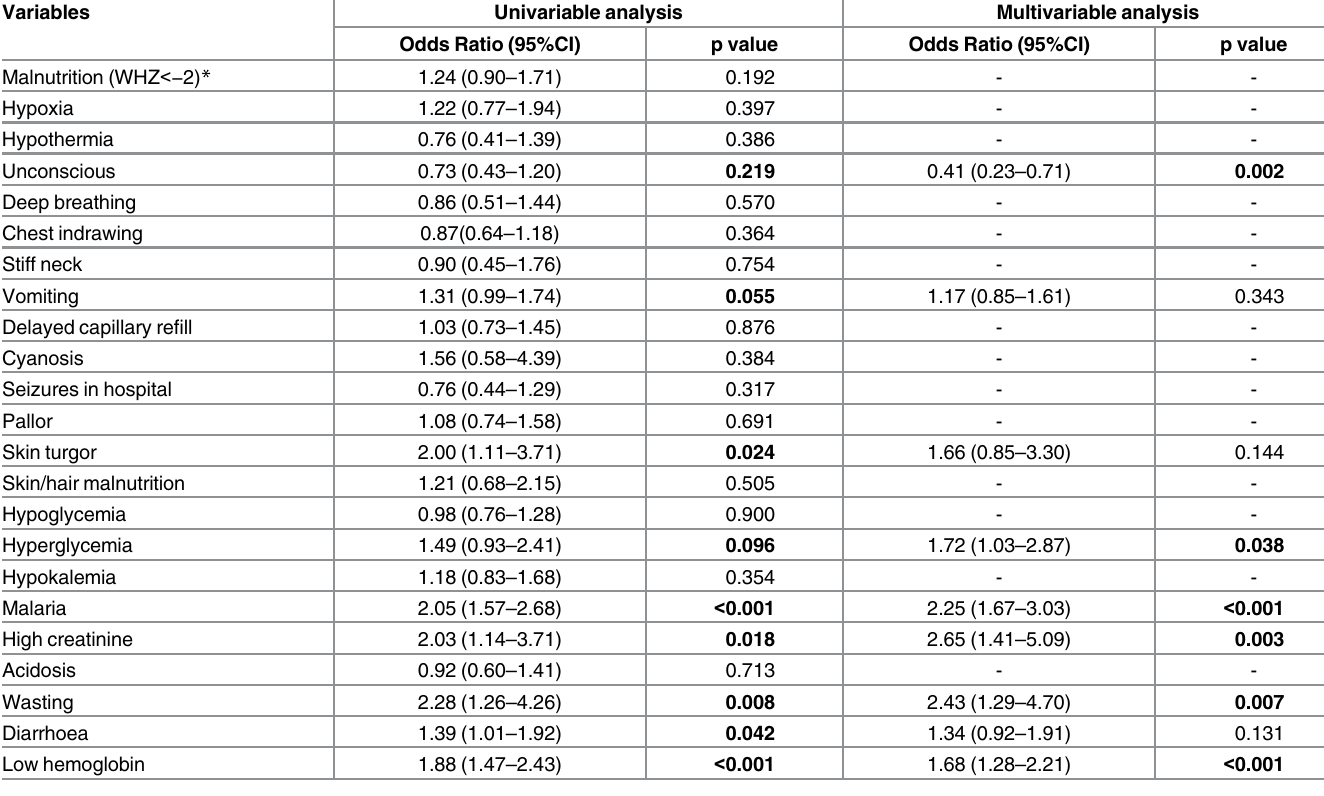
Table 3. Factors associated with